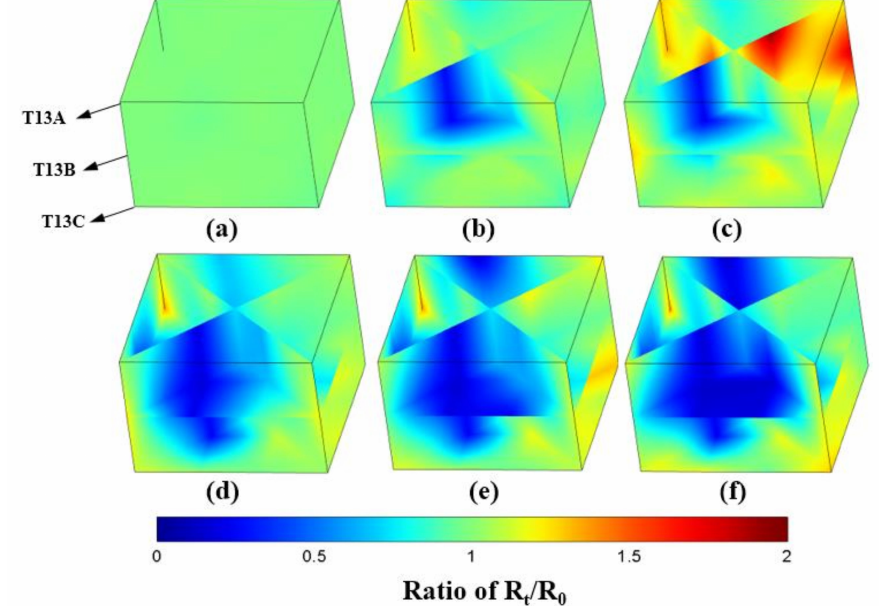
Figure 14. Space distributions of R t /R 0 ratios in the hydrate-bearing sediment from the starting point to the end point of hydrate dissociation. ( a ) 0 min, ( b ) 20 min, ( c ) 28 min, ( d ) 75 min, ( e ) 185 min, ( f ) 345